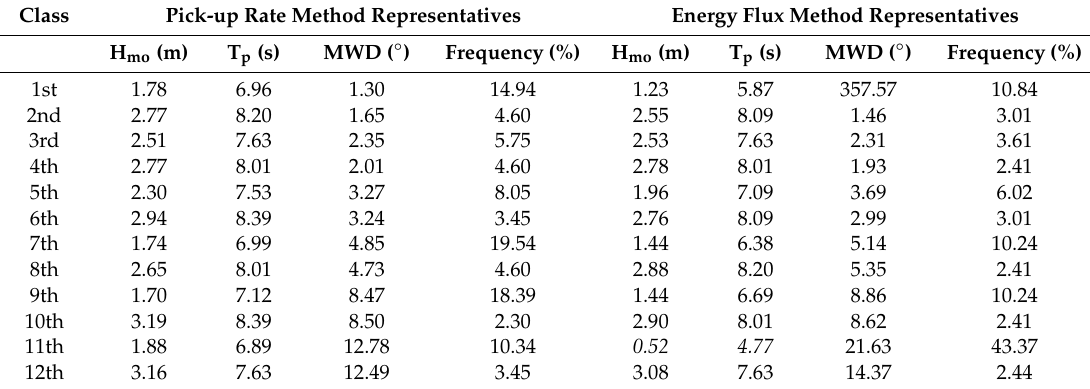
Table 1. Representative wave conditions from the time series of 7 days, using the pick-up rate and the energy-flux wave schematization methods.